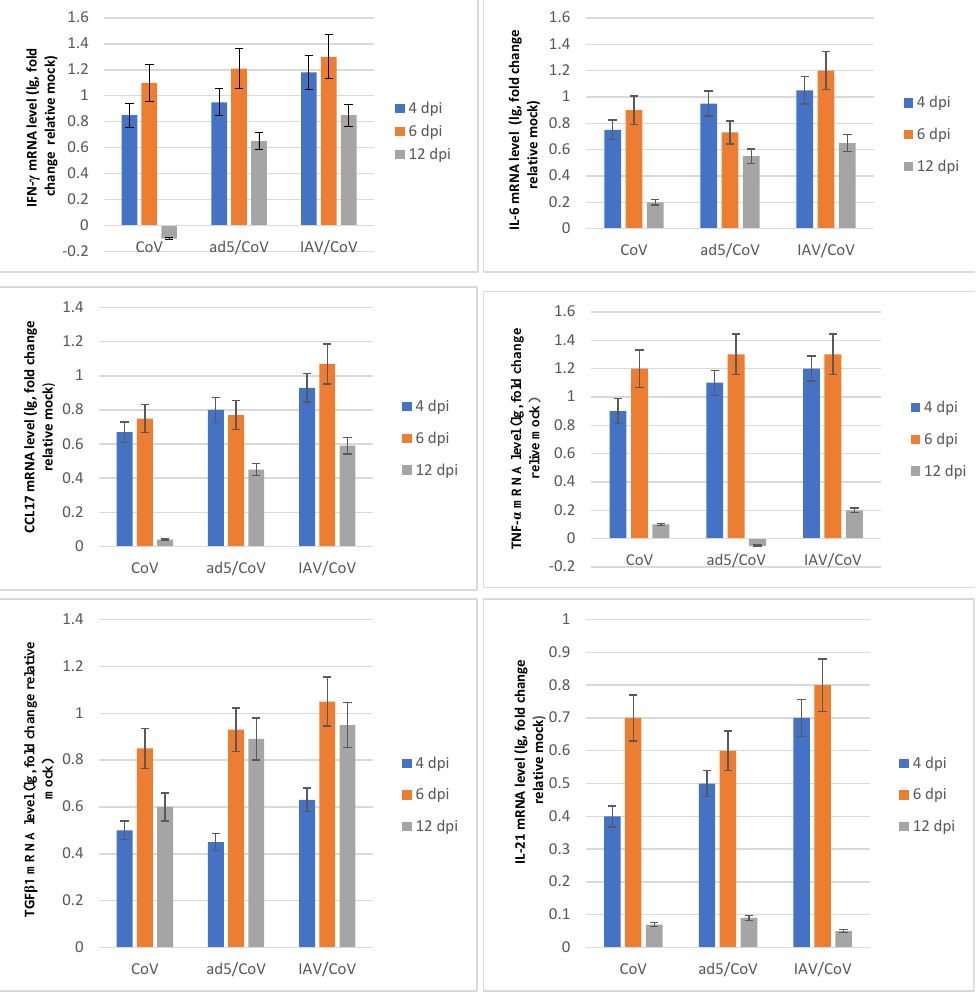
Figure 7. The chemokine/cytokine profile in the lungs of hamsters coinfected with SARS-CoV-2 and HAdV-5 or IAV. “CoV (SARS-CoV- 2)”— on Day 0, the hamsters were intranasally challenged with SARS-CoV-2 (10 5 TCID 50 ); “ad5 (HAdV - 5)/CoV”— on Day 0, the hamsters preinfected (3 days ear- lier) with HAdV-5 (10 6 TCID 50 ) were intranasally challenged with SARS-CoV-2 (10 5 TCID 50 ); IAV/CoV — on Day 0, the hamsters preinfected (4 days earlier) with IAV (2 × 10 3 TCID 50 ) were in- tranasally challenged with SARS-CoV-2 (10 4 TCID 50 ); dpi — day postinfection with SARS-CoV-2. The data are expressed as fold changes relative to the mock-infected group. The values represent the means ± SDs of three individual animals. Student’s t -test was used for two-group comparisons, p < 0.05.